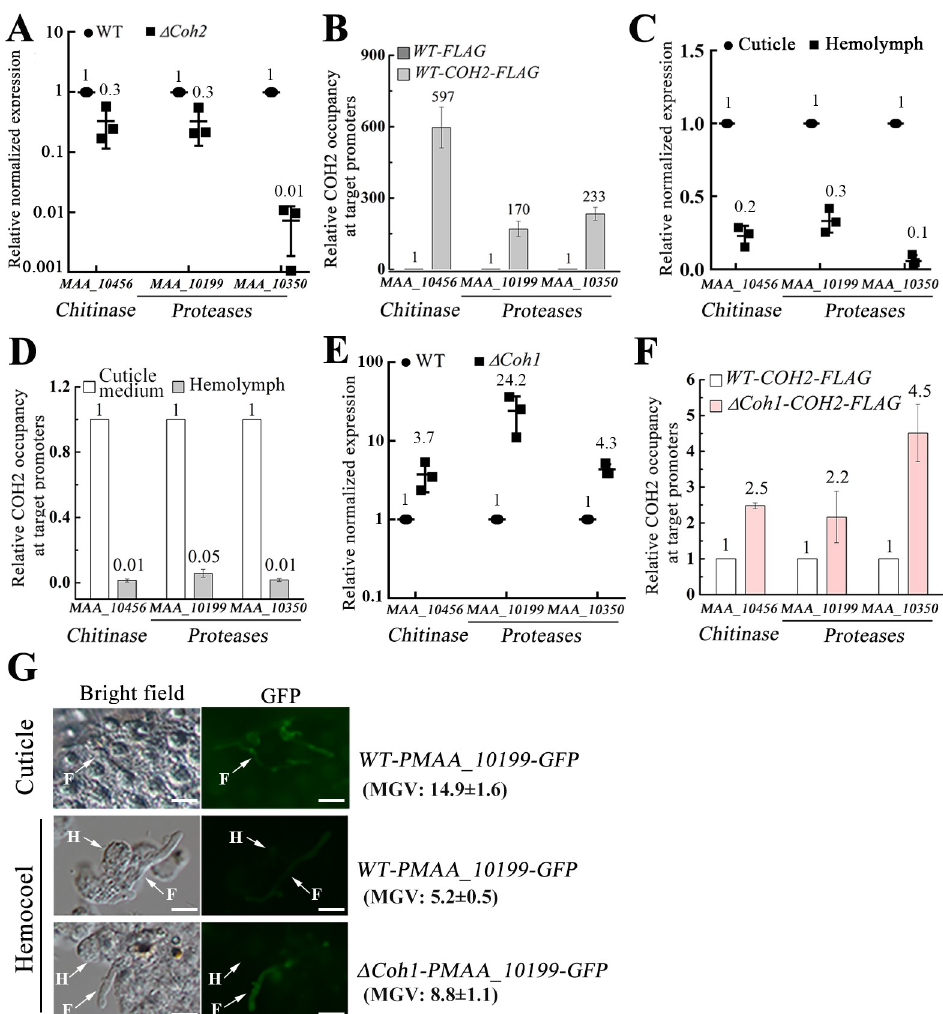
Fig 5. COH1 inactivates the COH2-mediated induction of cuticle-degrading genes during hemocoel colonization. (A) Quantitative reverse transcription PCR (qRT-qPCR) analysis of the expression of cuticle-degrading genes during cuticle penetration in the mutant Δ Coh2 relative to the wild-type (WT) strain. The chitinase MAA_10456 and the proteases MAA_10199 and MAA_10350 are used as representatives. (B) Chromatin immunoprecipitation quantitative PCR (ChIP-qPCR) analysis shows the occupancy of the COH2::FLAG protein in the promoters of the chitinase and protease genes in the strain WT-COH2-FLAG relative to occupancy in the control strain WT-FLAG , which is set to 1. The fungal strains were grown in the cuticle medium. (C) qRT-PCR analysis of the expression levels of the 3 genes during surrogate hemocoel colonization relative to the expression level during cuticle penetration, which is set to 1. (D) ChIP-qPCR analysis of the occupancy of COH2 in the promoters of the 3 genes during surrogate hemocoel colonization (Hemolymph) relative to the growth in the cuticle medium (Cuticle medium), which is set to 1. The strain WT-COH2-FLAG was used. (E) qRT-PCR analysis of the expression levels of the 3 genes during surrogate hemocoel colonization in the mutant Δ Coh1 relative to the expression level in the WT strain, which is set to 1. (F) ChIP-qPCR analysis of the occupancy of the COH2::FLAG protein in the promoters of the 3 genes during surrogate hemocoel colonization in the strain Δ Coh1-COH2-FLAG (the mutant Δ Coh1 with COH2::FLAG expressed) relative to occupancy in the strain WT-COH2-FLAG , which is set to 1. (G) GFP signal in the fungal cells of 2 strains ( WT-PMAA_10199-GFP and Δ Coh1-PMAA_10199-GFP ) with the gfp gene driven by the promoter of the protease gene MAA_10199 . Top panel: WT-PMAA_10199-GFP on the cuticle (Cuticle); middle panel: WT-PMAA_10199-GFP in the real hemocoel of G . mellonella larva infected by a fungal strain (Hemocoel); bottom panel: Δ Coh1-PMAA_10199-GFP in the real hemocoel. F, fungal cells; H, hemocyte; MGV, mean gray value. Scare bar, 10 μ m. The data underlying all the graphs shown in the figure can be found in S1